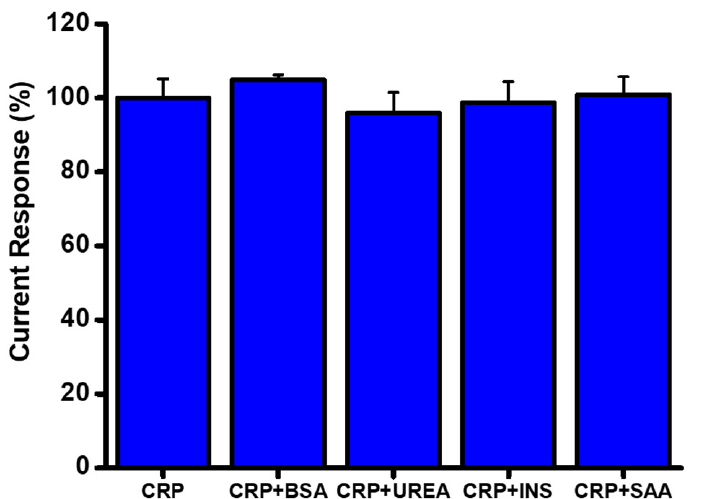
Figure 6. Interference effect of BSA, urea, INS, and SAA on the detection of CRP using PS/rGO-MNP-PDA/Anti-CRP (in the presence of 10 mL PBS (pH 7.4) solution containing 5 mM HCF and 0.1 M KCl; [CRP]: 20 ng/mL, [BSA]; 1 mg/mL, [Urea]:0.5 mg/mL, [INS]: 1 µ U/mL, [SAA]: 20 µ g/mL; scan rate: 50 mVs − 1 .) Error bars show the standard deviation of at least 3 replicate measurements.